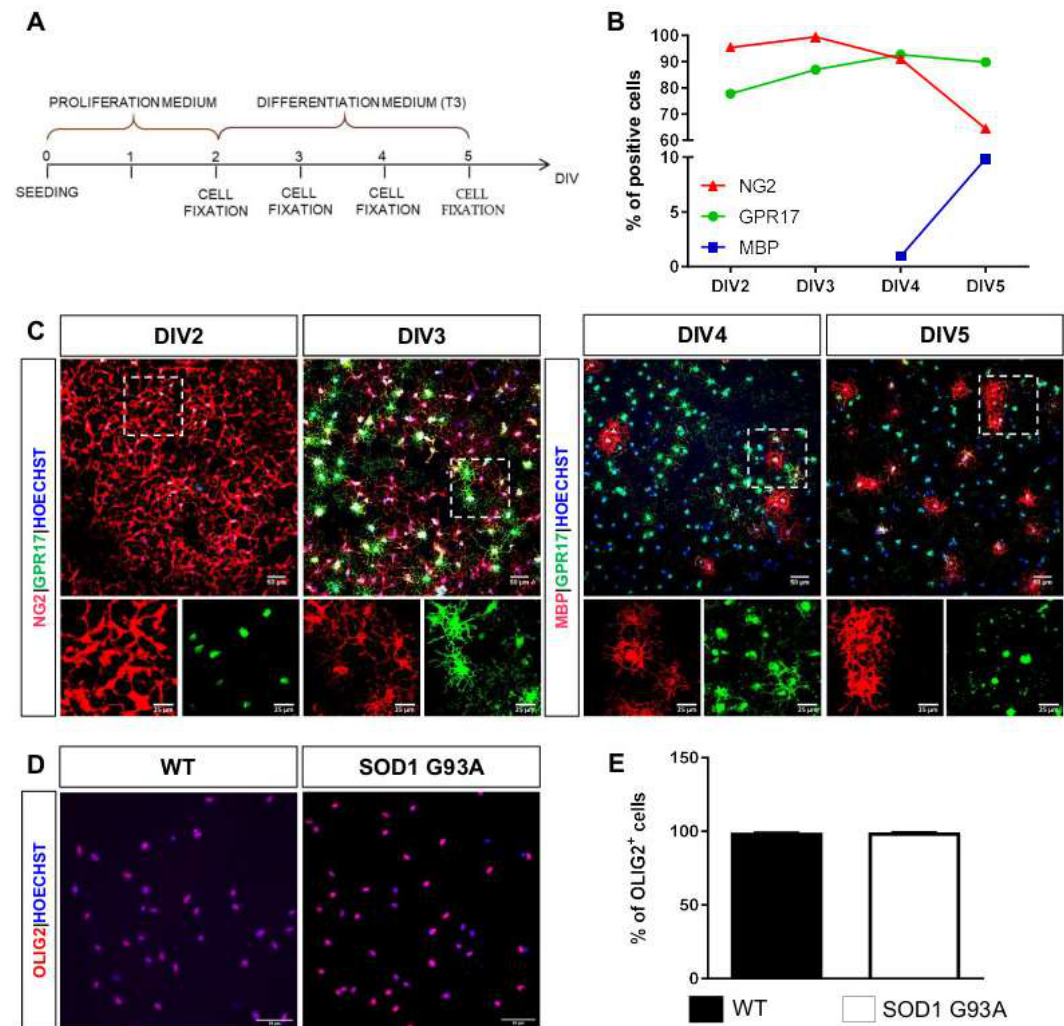
Figure A1. Set up and characterization of primary purified OPCs from spinal cord of P7 wild-type mice. ( A ) Representative experimental protocol scheme for OPC cultures. ( B ) Graph shows the quantification of the percentage of NG2, GPR17 and MBP positive cells at different time points during OPC differentiation. Data are the mean of cell counts from a total of 3 coverslips/condition from seven independent experiments. ( C ) Representative images of cells fixed at DIV2, DIV3, DIV4 and DIV5 showing double immunostaining for GPR17 together with either NG2 or MBP. Hoechst33258 was used to label cell nuclei. Scale bar: 50 µm. Insets show higher magnification of representative GPR17+ cells at different stages of differentiation process, appearing with different morphologies. Scale bar: 25 µm. ( D ) Representative images of OLIG2 staining in primary OPC cultures from spinal cord of WT and SOD1G93A mice. Hoechst33258 was used to label cell nuclei. Scale bar: 50 µm. ( E ) Histograms showing the quantification of the percentage of OLIG2 + cells in OPC cultures from WT and SOD1 G93A mice. Data are the mean ± SE of cell counts from at least 3 coverslips/condition from 2 independent experiments.